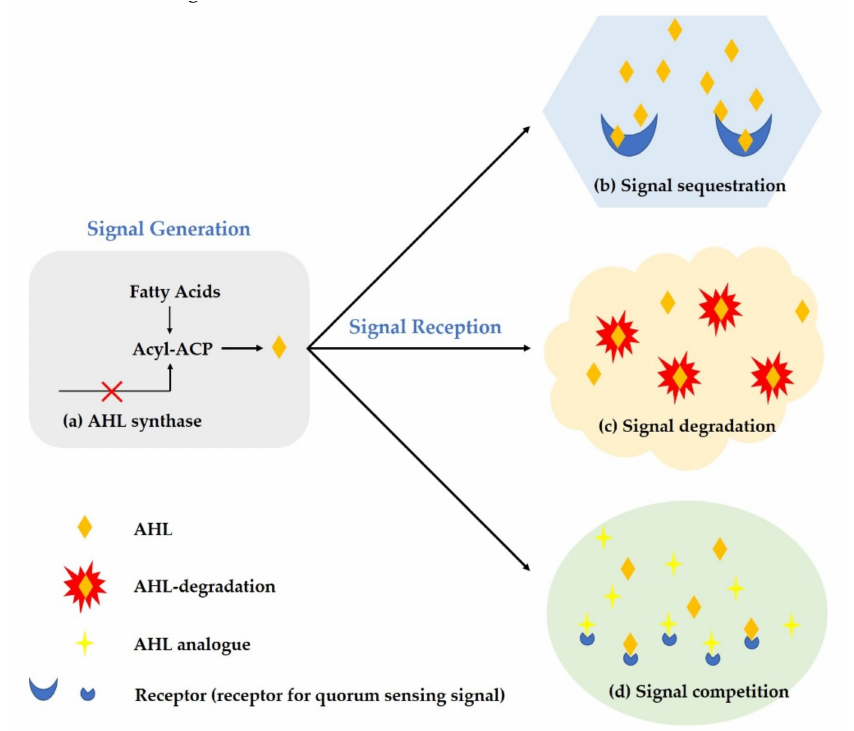
Figure 5. Schematic diagram of the quorum-sensing inhibitor